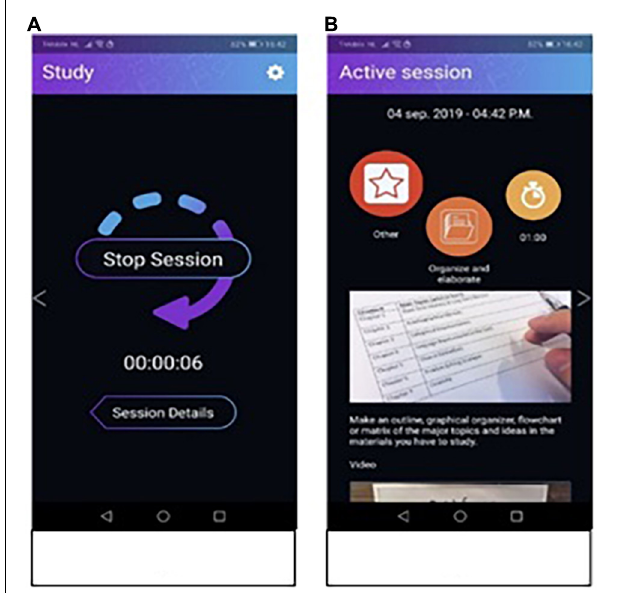
FIGURE 2 | Screenshots from the performance phase. Panel (A) shows the defaults screen during the performance phase which shows a timer. Panel (B) shows the summary of the “study plan” made in the forethought phase.